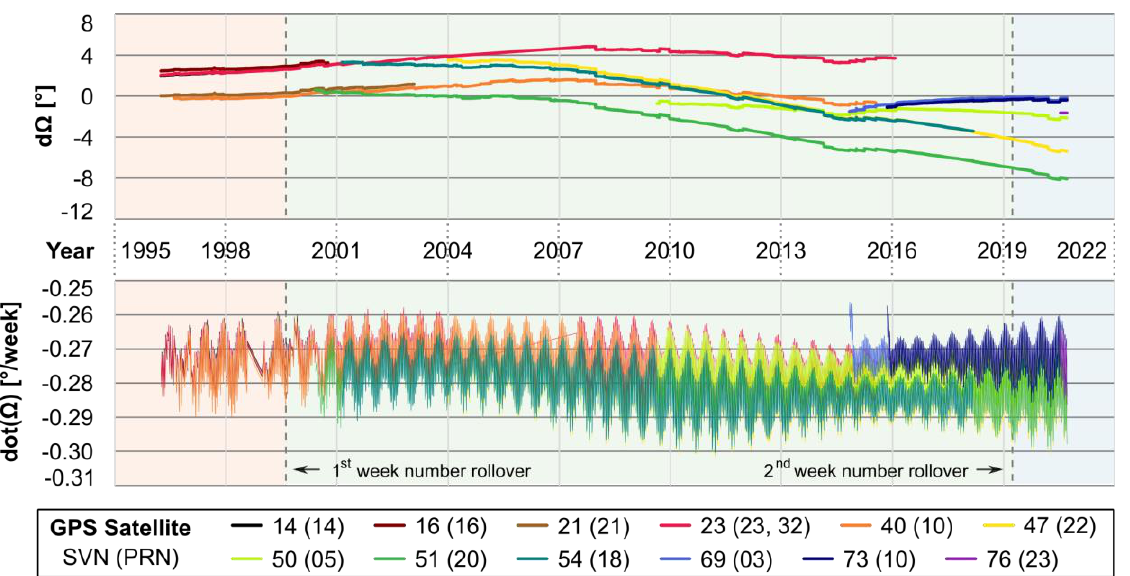
Figure A4. Separation of satellite ANs from the hex-LS-estimated position of the OP E AN with satellite dot(Ω) values. Table A5. Descriptive parameters of the OP F satellites.